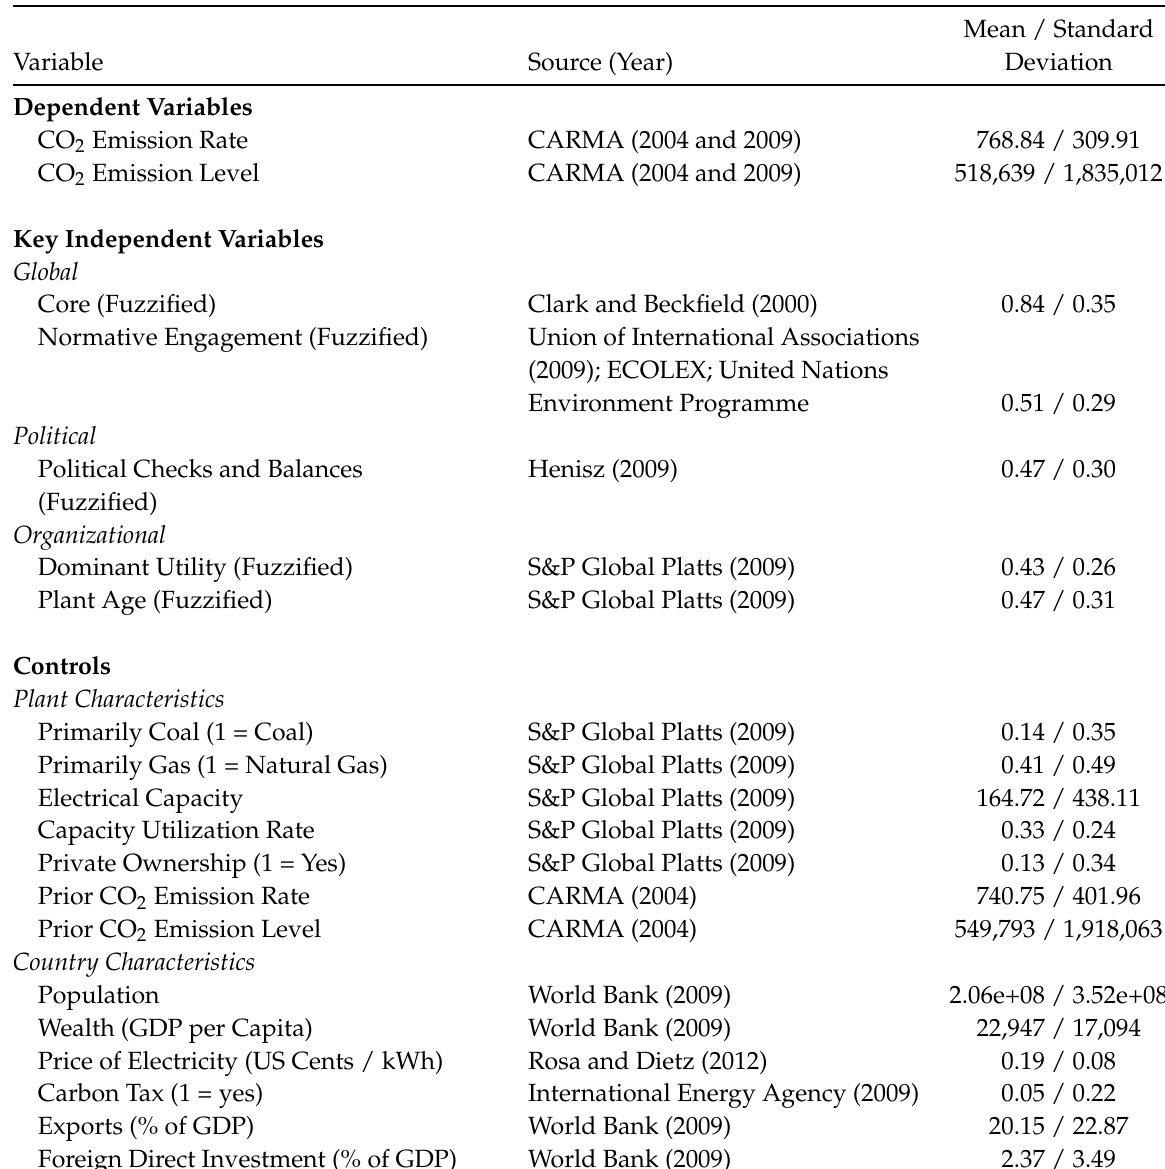
Table 5: Variable